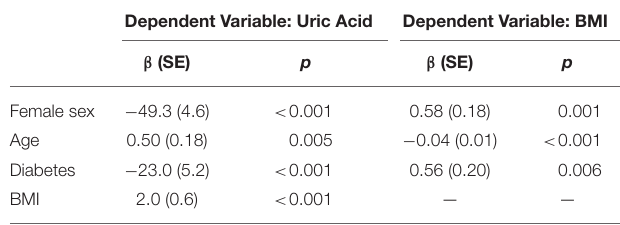
TABLE 1 | Characteristics of ischemic stroke patients by sex groups. TABLE 2 | Relationship between uric acid, BMI, age, sex, and